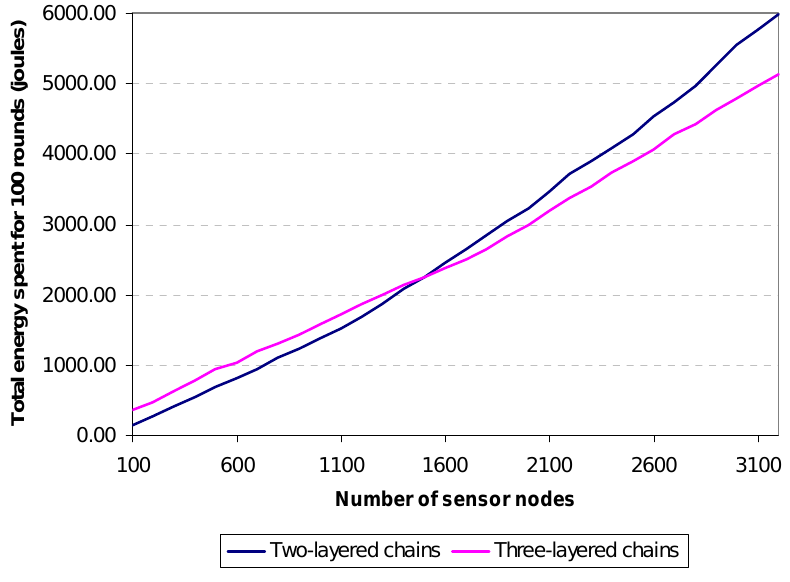
Figure 18. Energy consumption differences between two-layered and three-layered